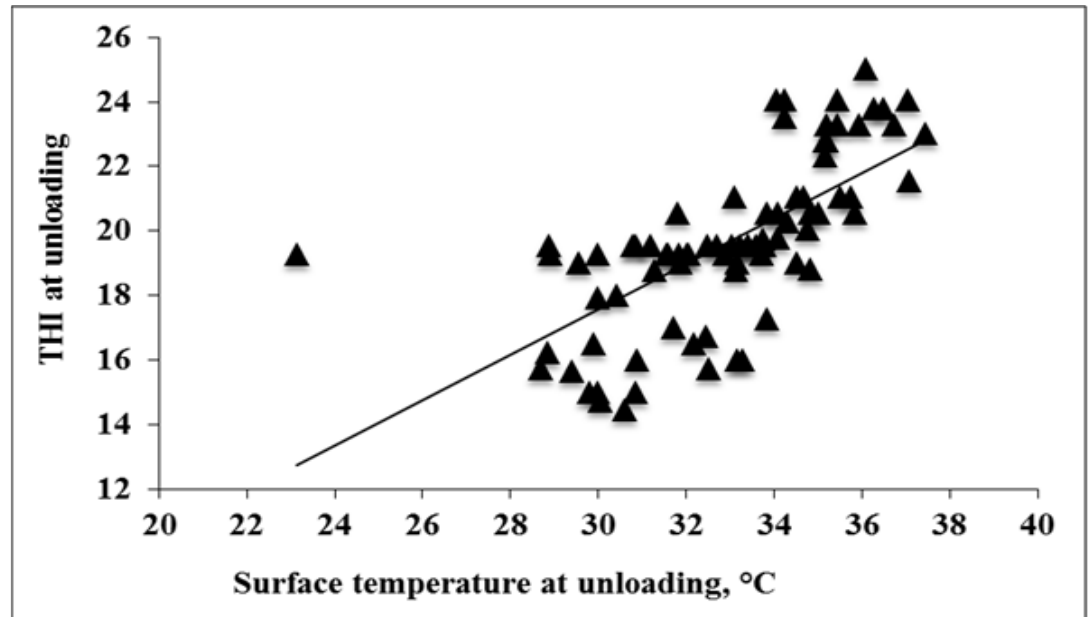
Figure 1. Experiment 1. Effects of temperature humidity index (THI) at unloading on surface temperature of pigs at unloading ( p < 0.01; R 2 =